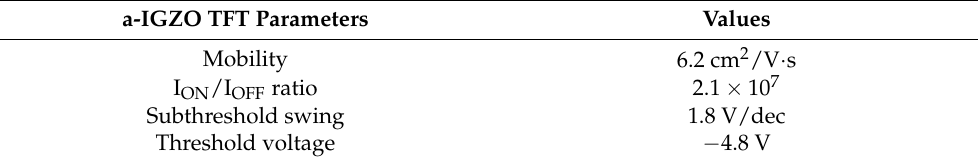
Table 3. The electrical parameters of the fabricated a-IGZO TFT.